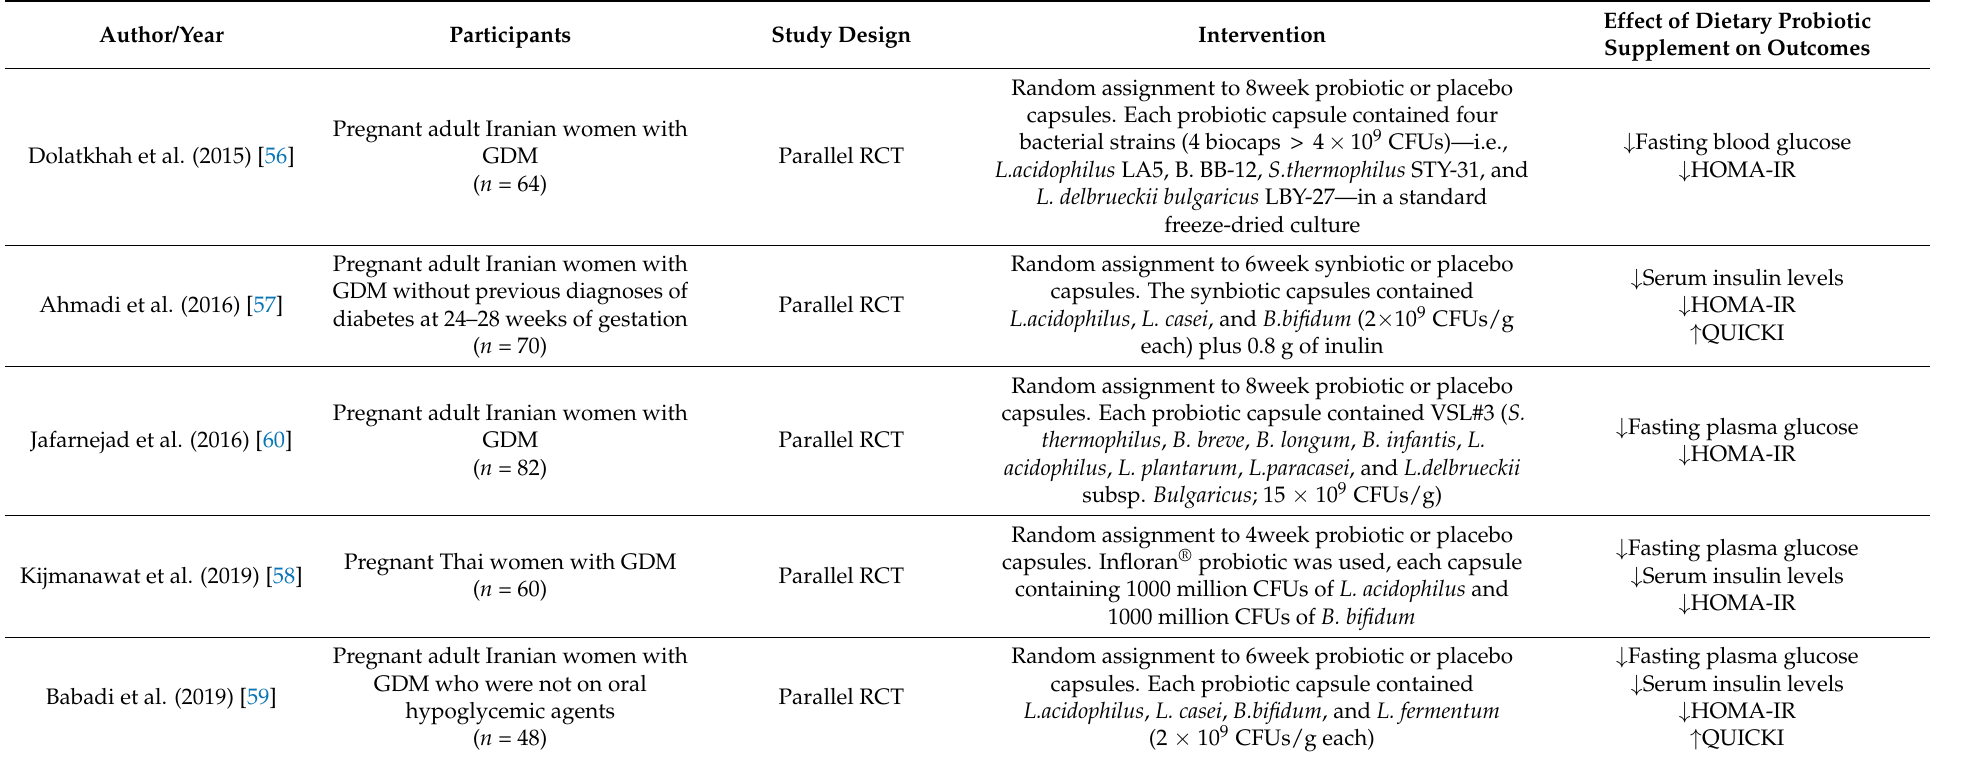
Table 3. Characteristics of randomized controlled trials included in Section 3.2